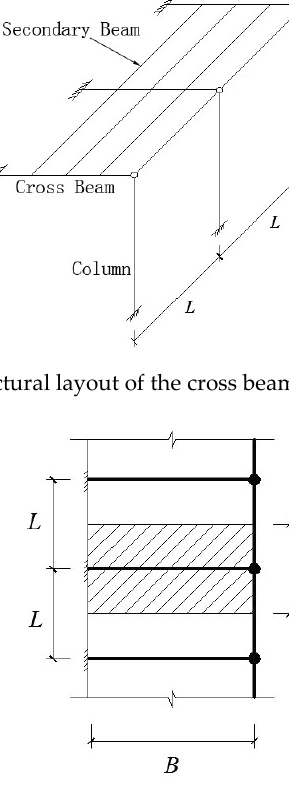
Figure 10. Planning for the calculation element of the cross beam and column plank